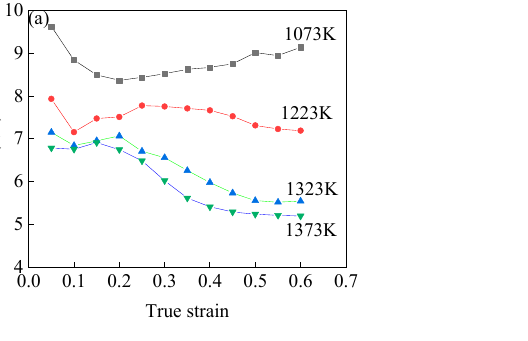
Figure 12. The value of n ( ε , T ) under different deformation conditions: ( a ) the experimental results, ( b ) the fitting results.